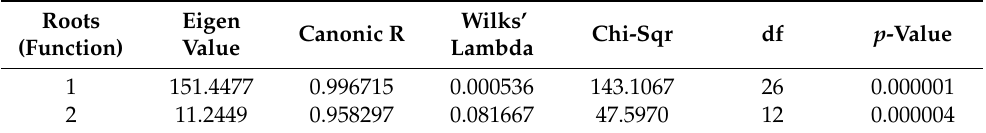
Table 8. Chi-square tests with successive roots